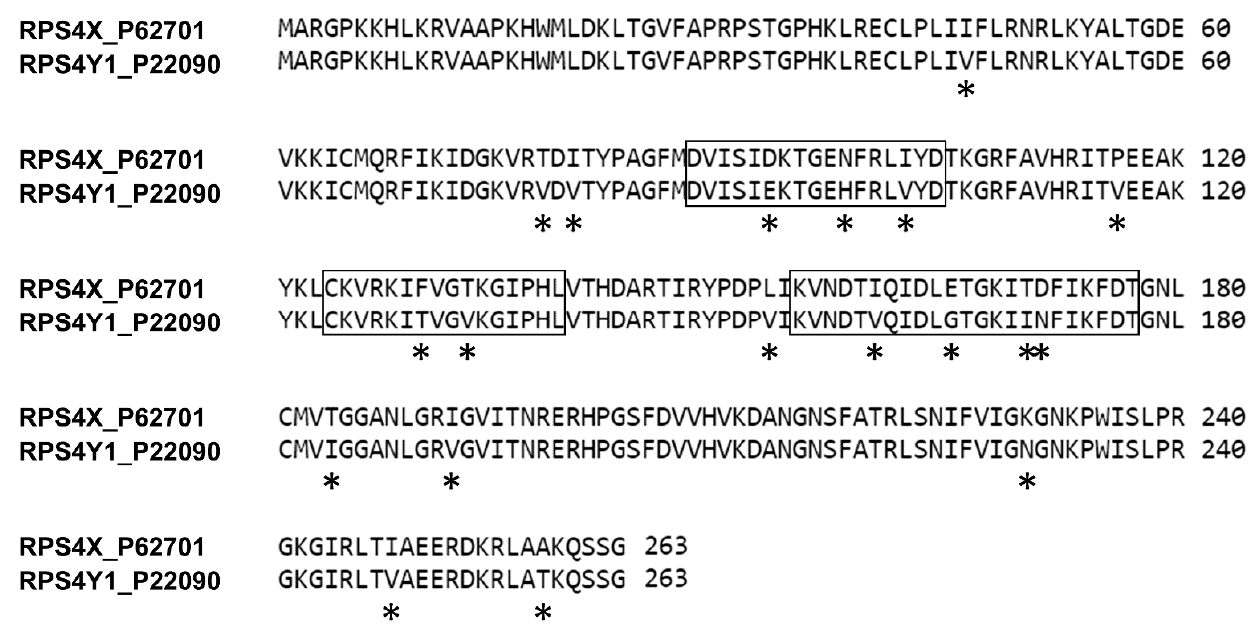
Figure 2. Alignment of RPS4X and RPS4Y1 amino acid sequences. Amino acid difference between the two proteins are indicated by asterisks (  ). Regions selected as antigens for mice immunization are boxed.